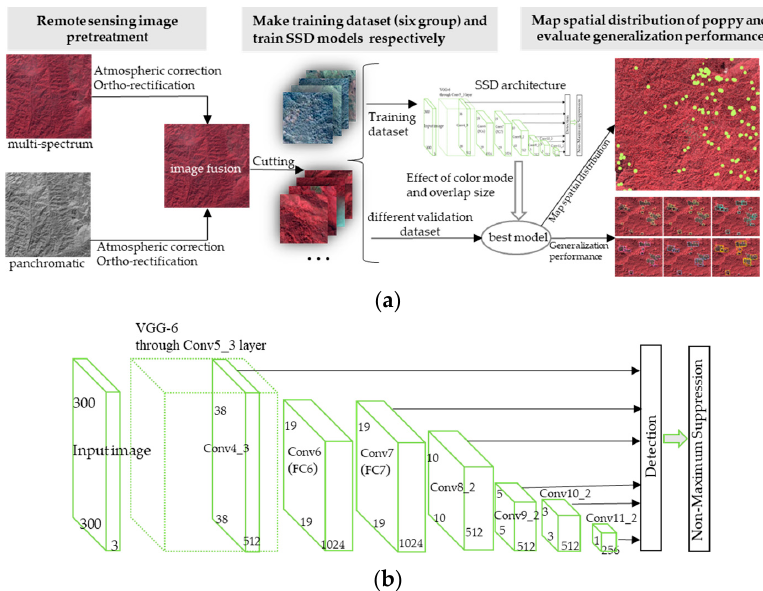
Figure 2. Workflow of the method: ( a ) diagram of the methodological framework, ( b ) a detailed description of the single shot multibox detector (SSD) architecture.